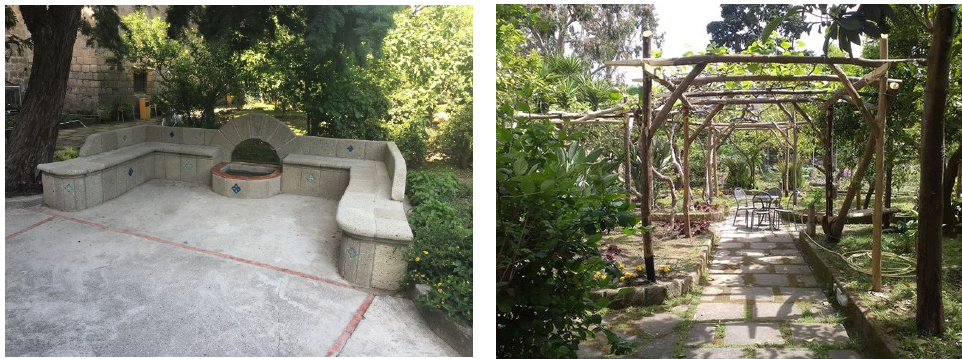
Figure 11. Bench and Trellis designed and made at Building Beauty in 2018 and 2019 [23].